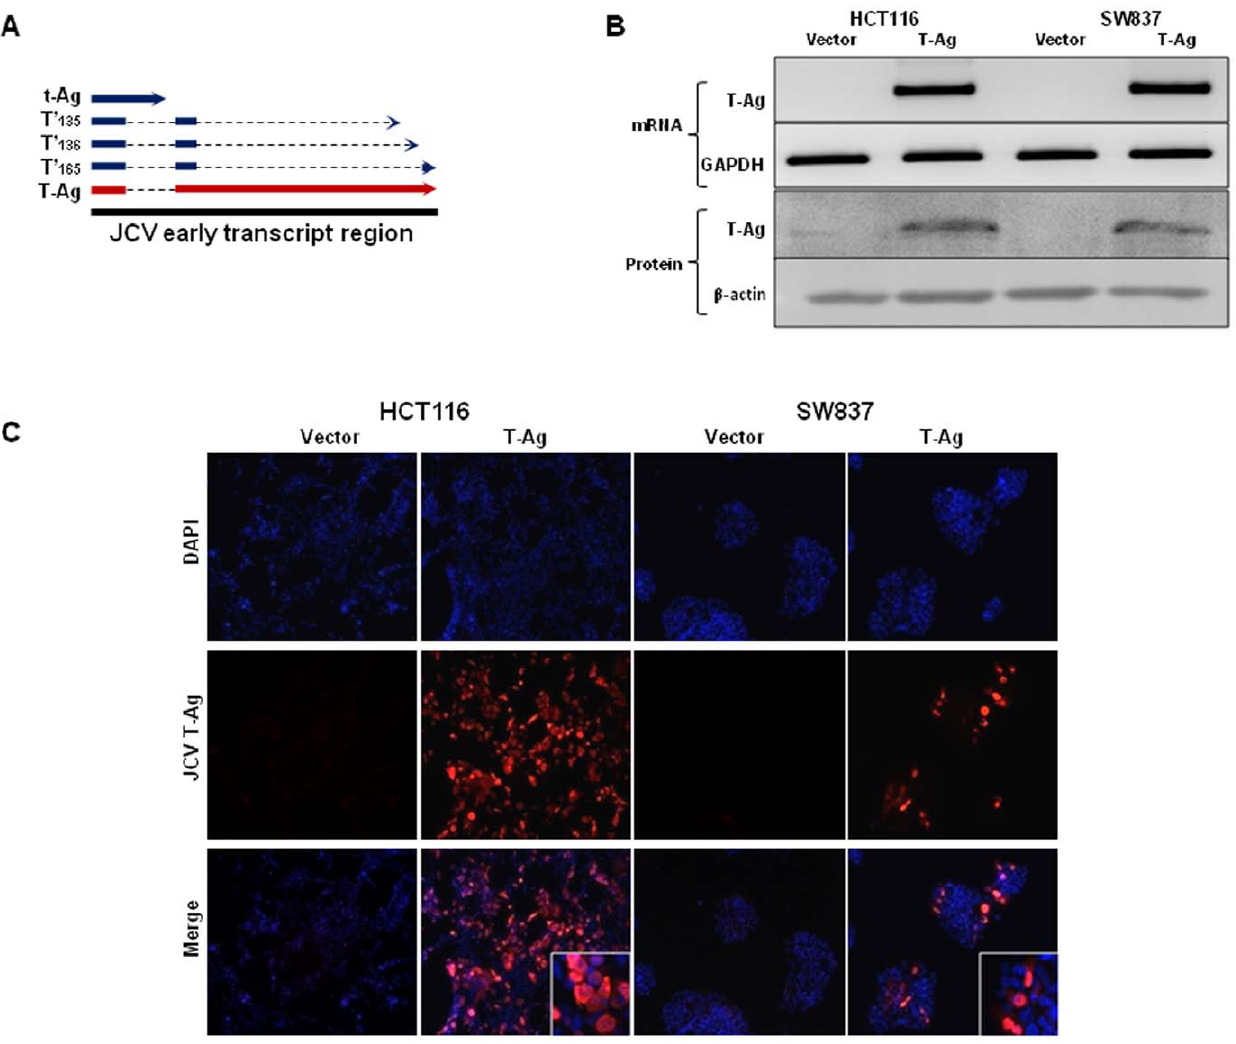
Figure 1. JCV T-Ag expression in transfected colorectal cancer cells. (A) An illustration of the JCV early transcript region that codes for 5 early transforming proteins, T-Ag, t-Ag and the 3 splice variants T’ 165 , T’ 136 , T’ 135 . T-Ag is predominant protein expressed after transfection (marked in red). (B) RT-PCR and Western immunoblotting gel images depicting JCV T-Ag specific mRNA and protein expression in stably transfected cells (indicated as T-Ag), while no T-Ag expression was observed in control cell lines (V, vector transfected). GAPDH (RT-PCR) and b -actin (WB) were used as loading controls. (C) Immunofluorescence staining with JCV T-Ag antibody shows nuclear expression of JCV T-Ag in transfected HCT116 and SW837 cells lines. The images were taken at a final magnification of 630 6